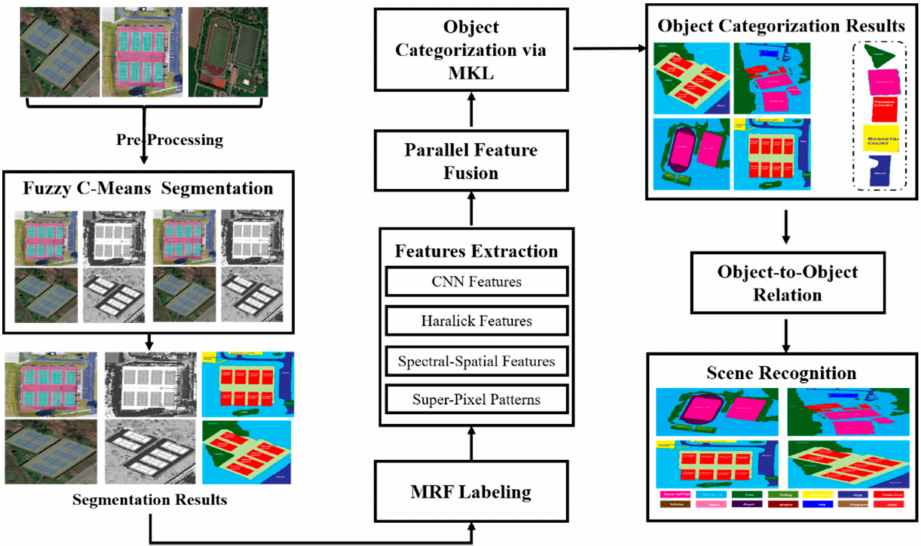
Figure 1. A schematic view of the proposed model over the